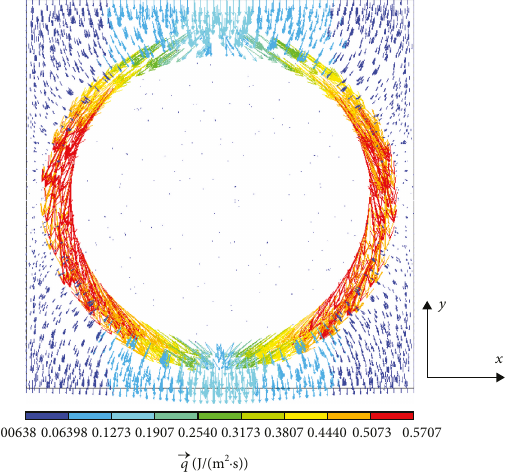
Figure 18: Pro fi le image of the heat fl ow vector of the wrapper model.